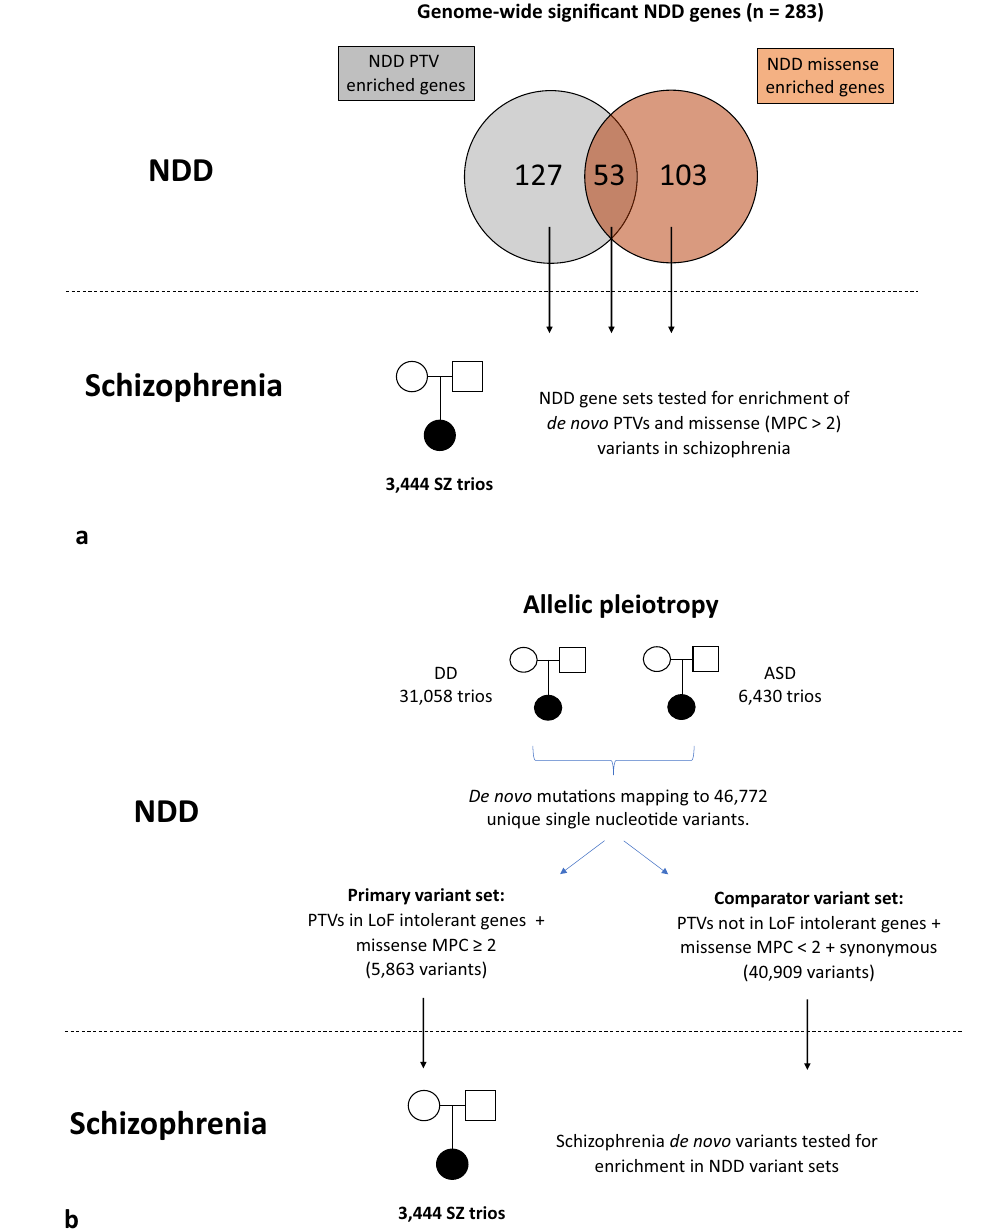
Fig. 1 Study design for analysis of genic and allelic pleiotropy. a Study design for analysis of genic pleiotropy. Genes enriched for protein-truncating variants or missense variants in neurodevelopmental disorders with a P value <2.5 × 10 − 6 were identi fi ed from the Deciphering Developmental Disorders study 14 . For each NDD gene set, the observed and expected number of de novo variants in 3444 schizophrenia trios was compared using a two-sided two- sample Poisson rate ratio test. See Methods for further details. b Study design for analysis of allelic pleiotropy. Neurodevelopmental disorder variants were de fi ned as de novo mutations reported in the largest sequencing studies of developmental disorders 14 and autism spectrum disorders 32 . Neurodevelopmental disorder variants were strati fi ed into a NDD primary variant set, de fi ned as those alleles annotated as protein-truncating variants affecting loss-of-function intolerant genes or missense variants with an MPC score ≥ 2. The remaining neurodevelopmental disorder variants (protein- truncating variants not affecting loss-of-function intolerant genes, missense variants with an MPC score ≤ 2 and synonymous variants) were grouped into a NDD comparator variant set. The observed and expected number of schizophrenia de novo variants overlapping alleles within each NDD variant set was compared using a two-tailed Poisson exact test. See Methods for further details. NDD, neurodevelopmental disorder; SZ, schizophrenia; DD, developmental disorder; ASD, autism spectrum disorder; PTV, protein-truncating variant; MPC, “ Missense badness, Polyphen-2, Constraint ” pathogenicity score 29